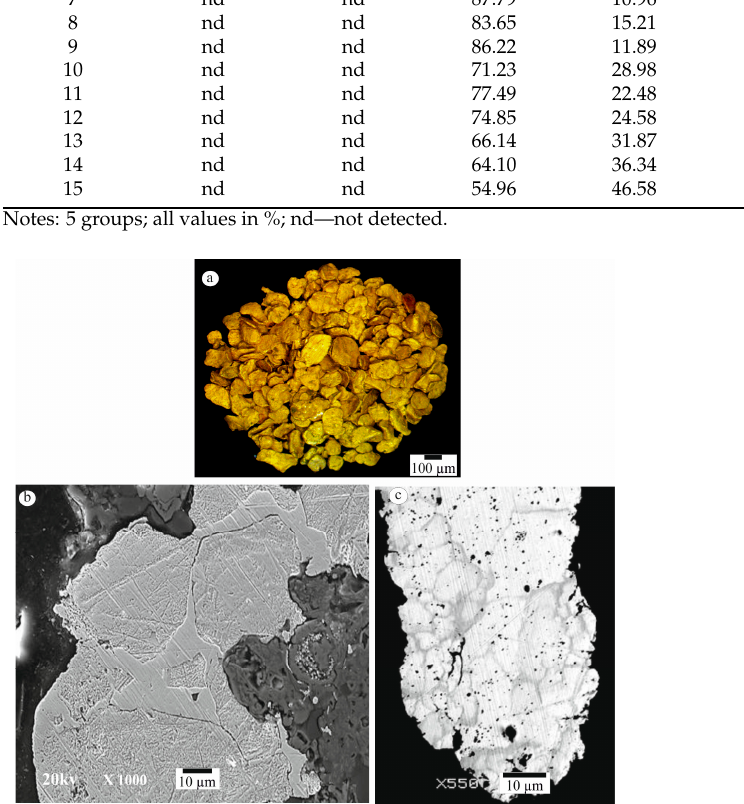
Figure 7. Morphology and internal structure of gold of the Nebaibyt river placer: ( а ) lamellar gold (general view); ( b ) very high-grade (990‰) intergranular veinlets in high-grade gold (950‰); ( c ) granulation structures of high-grade gold, etched with a reagent based on aqua regia; ( b , c ) shot in BSE mode.